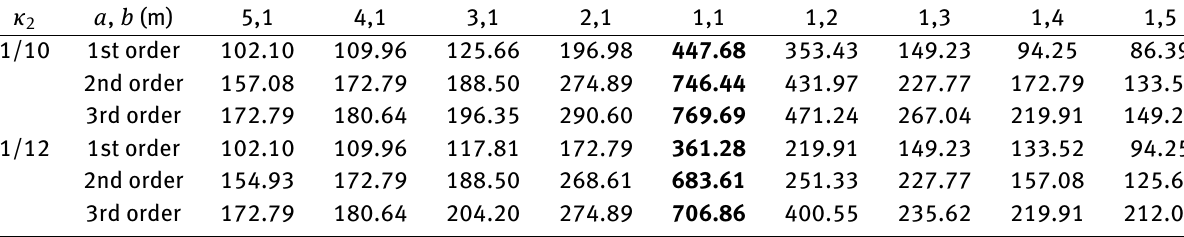
Table 7: The natural frequencies (rad/s) of numerical solutions under different length width ratios and rise span ratios κ 2